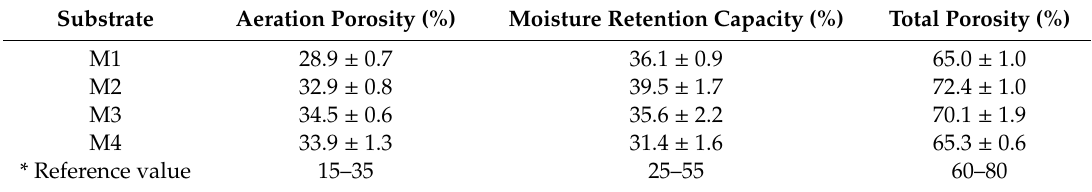
Table 2. Physical properties (mean ± standard error) of the substrate mixtures used in the production of Pinus cembroides Zucc. in